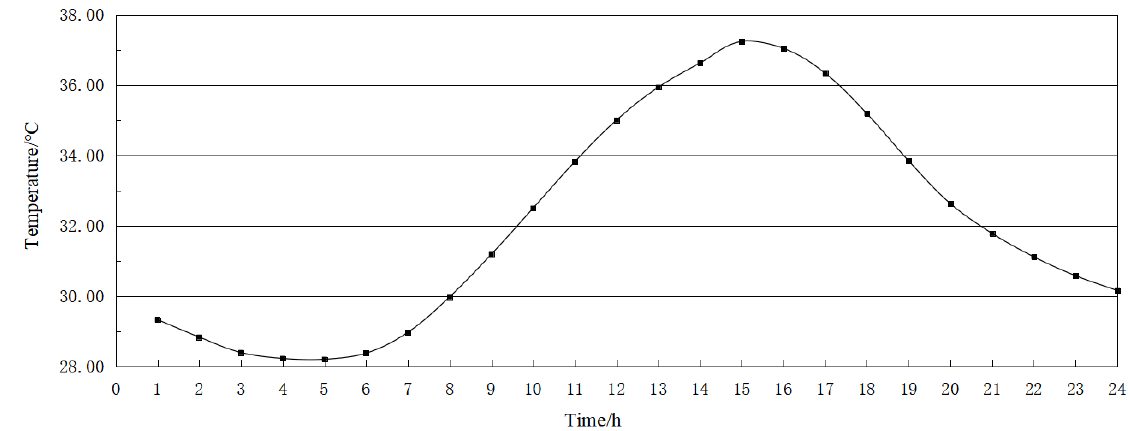
Figure 3. Temperature meteorological model of standard day in July in Beijing.